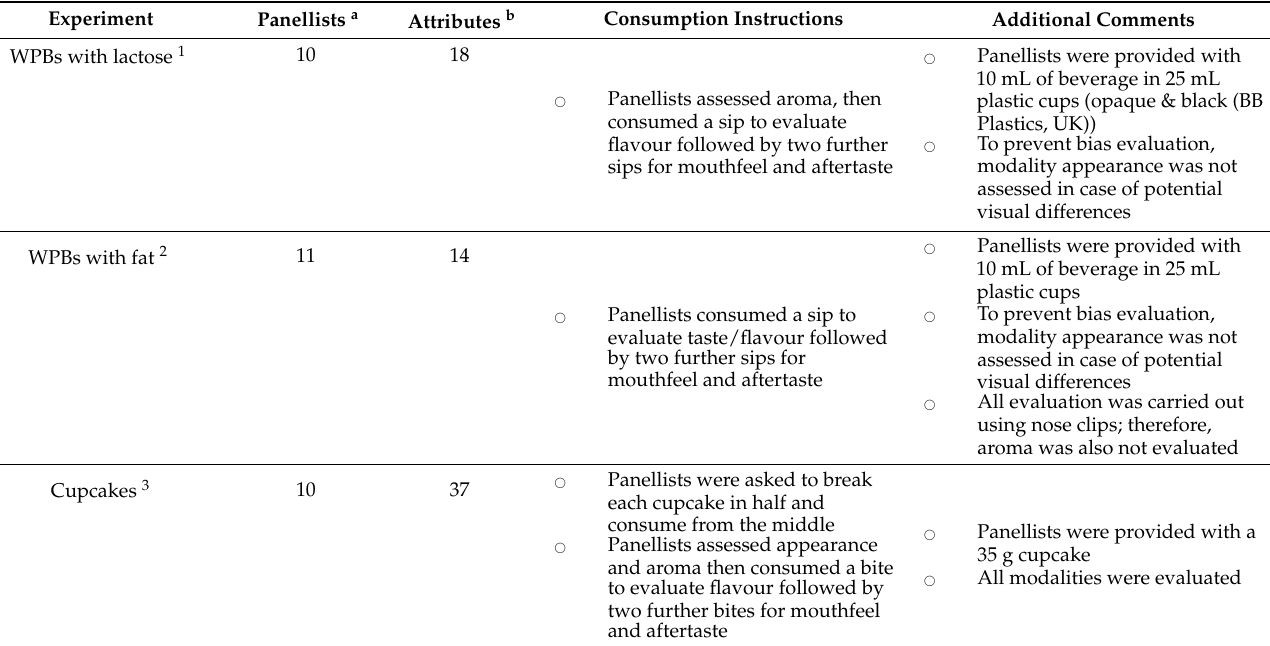
Table 4. Overview of sensory profile modifications for each